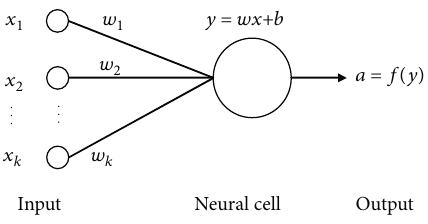
Figure 1: The structure of a